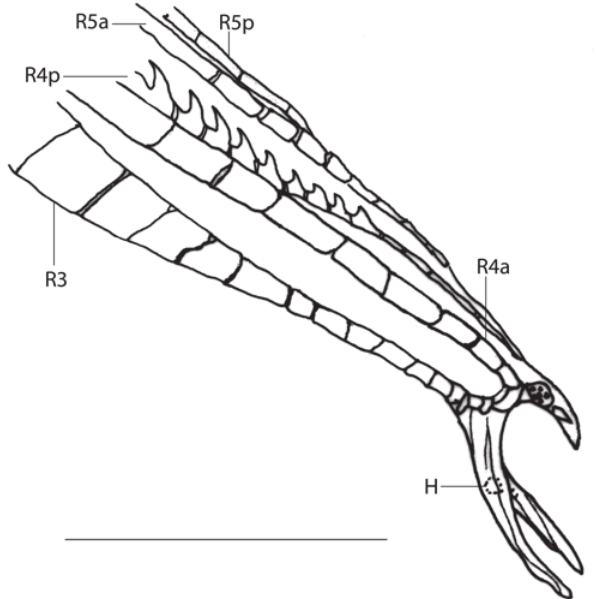
Fig. 14. Gonopodium tip of Phalloceros tupinamba , MCP 20585. R3, R4a, R4p, R5a, R5p indicate gonopodial rays. Scale bar 1